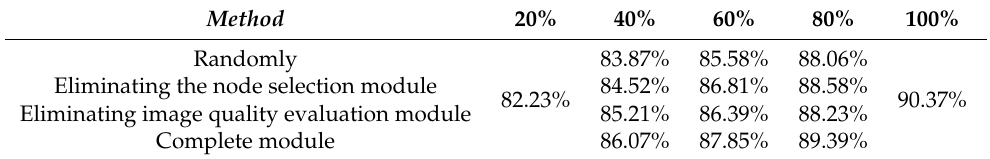
Table 2. Ablation study on